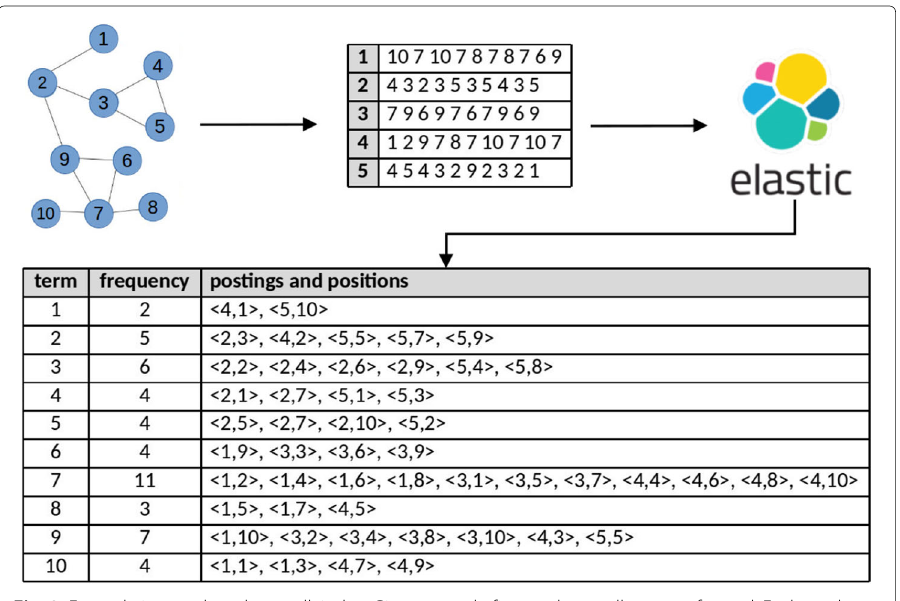
Fig. 3 Example inverted random walk index. Given a graph, five random walks are performed. Each random walk is treated as a document and is indexed using an open-source distributed indexing and searching library. The result is an inverted index that provides information about the frequency of any node in the random walks and information about where in the random walk the node is